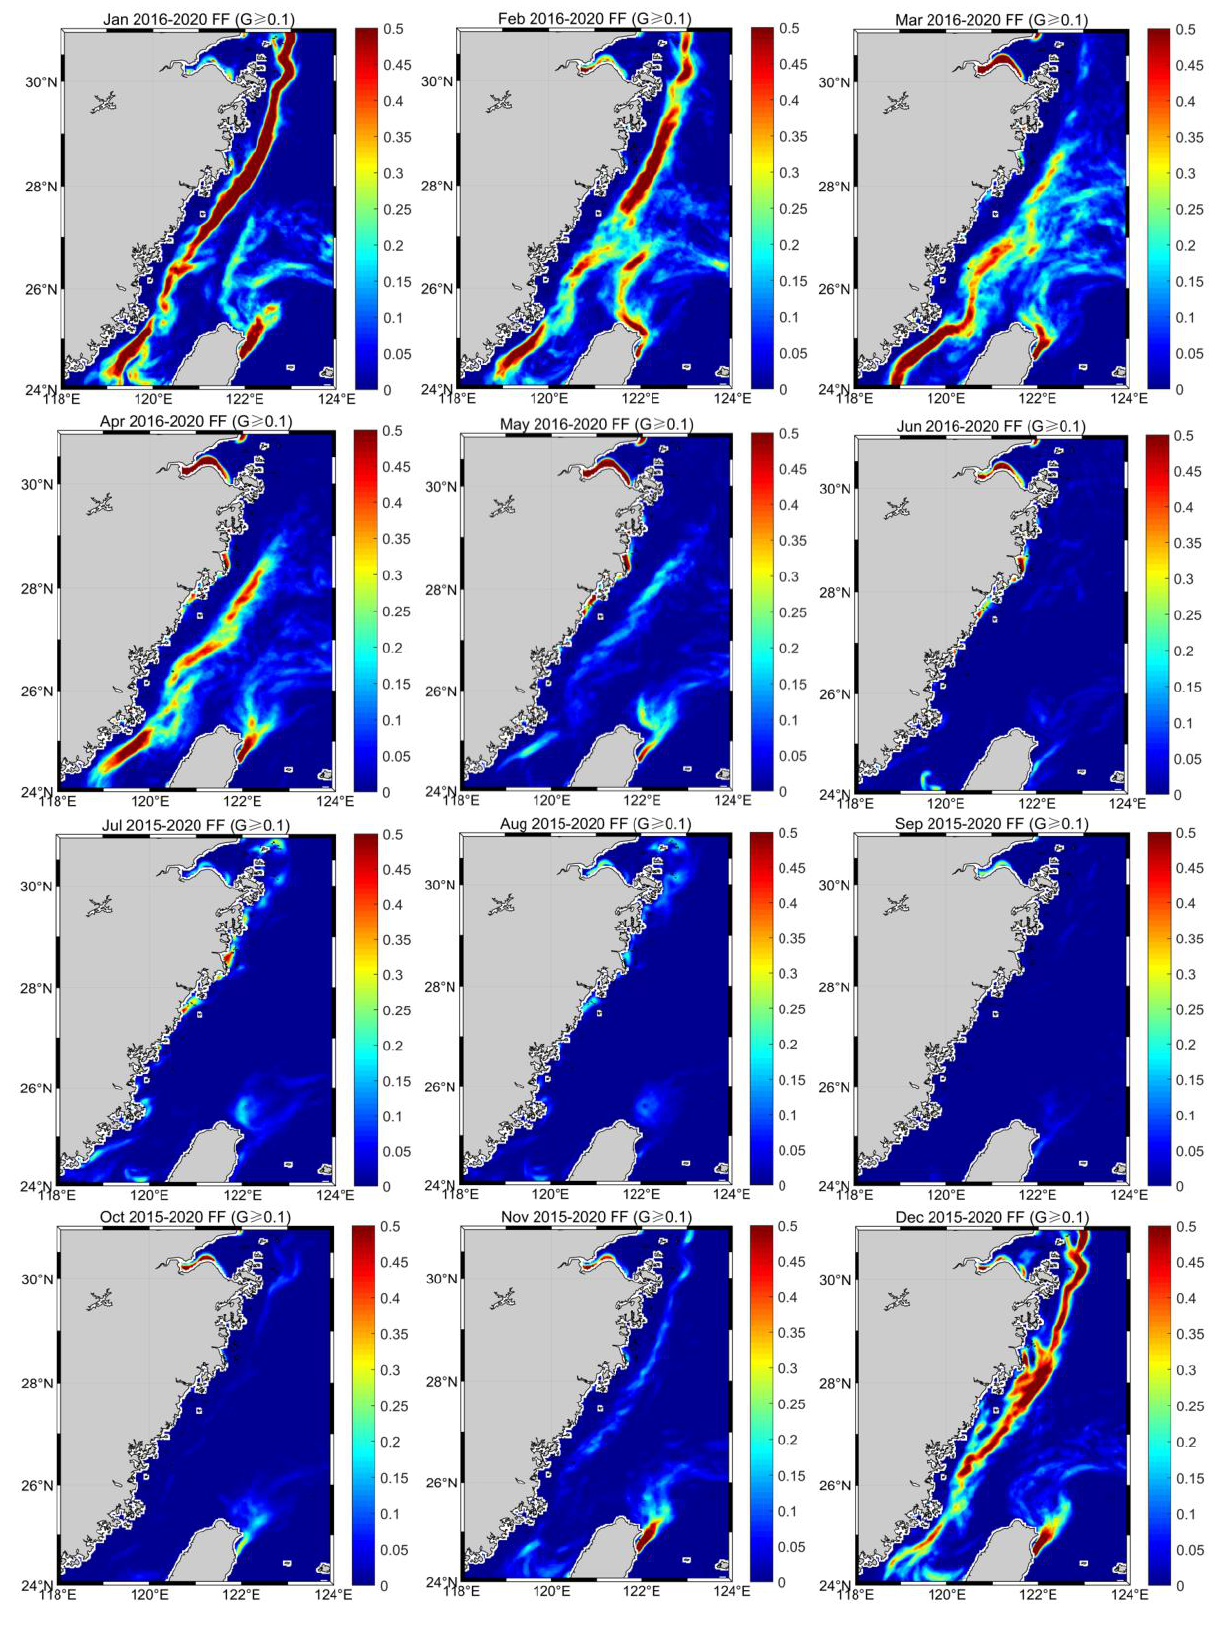
Figure 6. Long-term (2015 – 2020) mean monthly maps of frontal frequency FF at GM ≥ 0.1 °C/km.